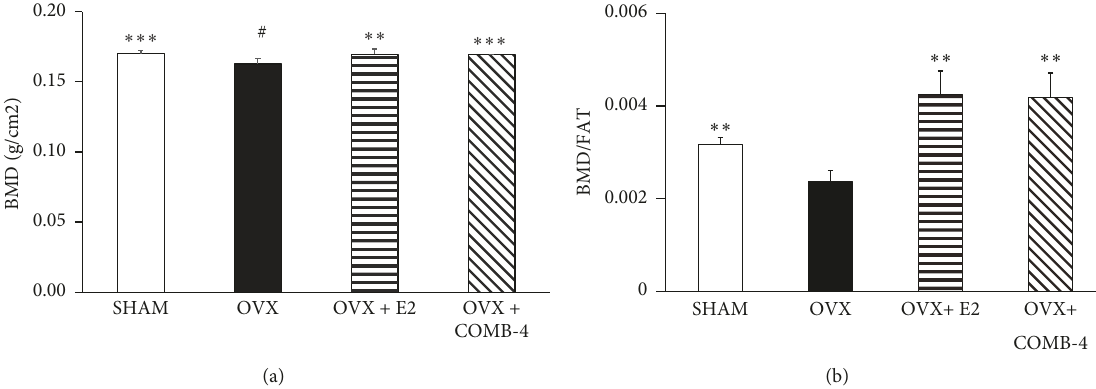
Figure 2: Effect of 100 days treatment with E2 or COMB-4 on Bone Mineral Density following OVX. Panel (a): bone mineral density (BMD; g/cm2 + SEM) determined by DXA scan in SHAM, OVX, E2(OVX+E2), and COMB-4 (OVX+COMB-4). ∗ ∗ ∗ p < 0.001; ∗∗ p < 0.01 with respect to OVX; # p < 0.05 respect to SHAM. Panel (b): BMD normalized by fat content in SHAM. OVX, E2 (OVX+E2), and COMB-4